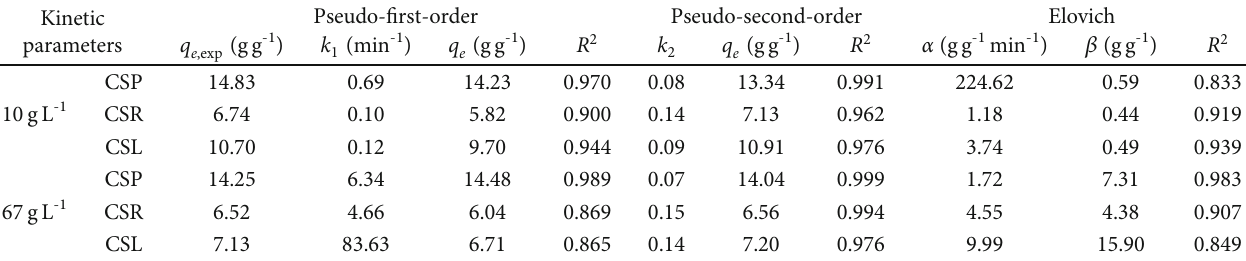
Table 6: Kinetic parameters for adsorption of two concentrations of the oil-water solution. Pseudo- fi Kinetic parameters